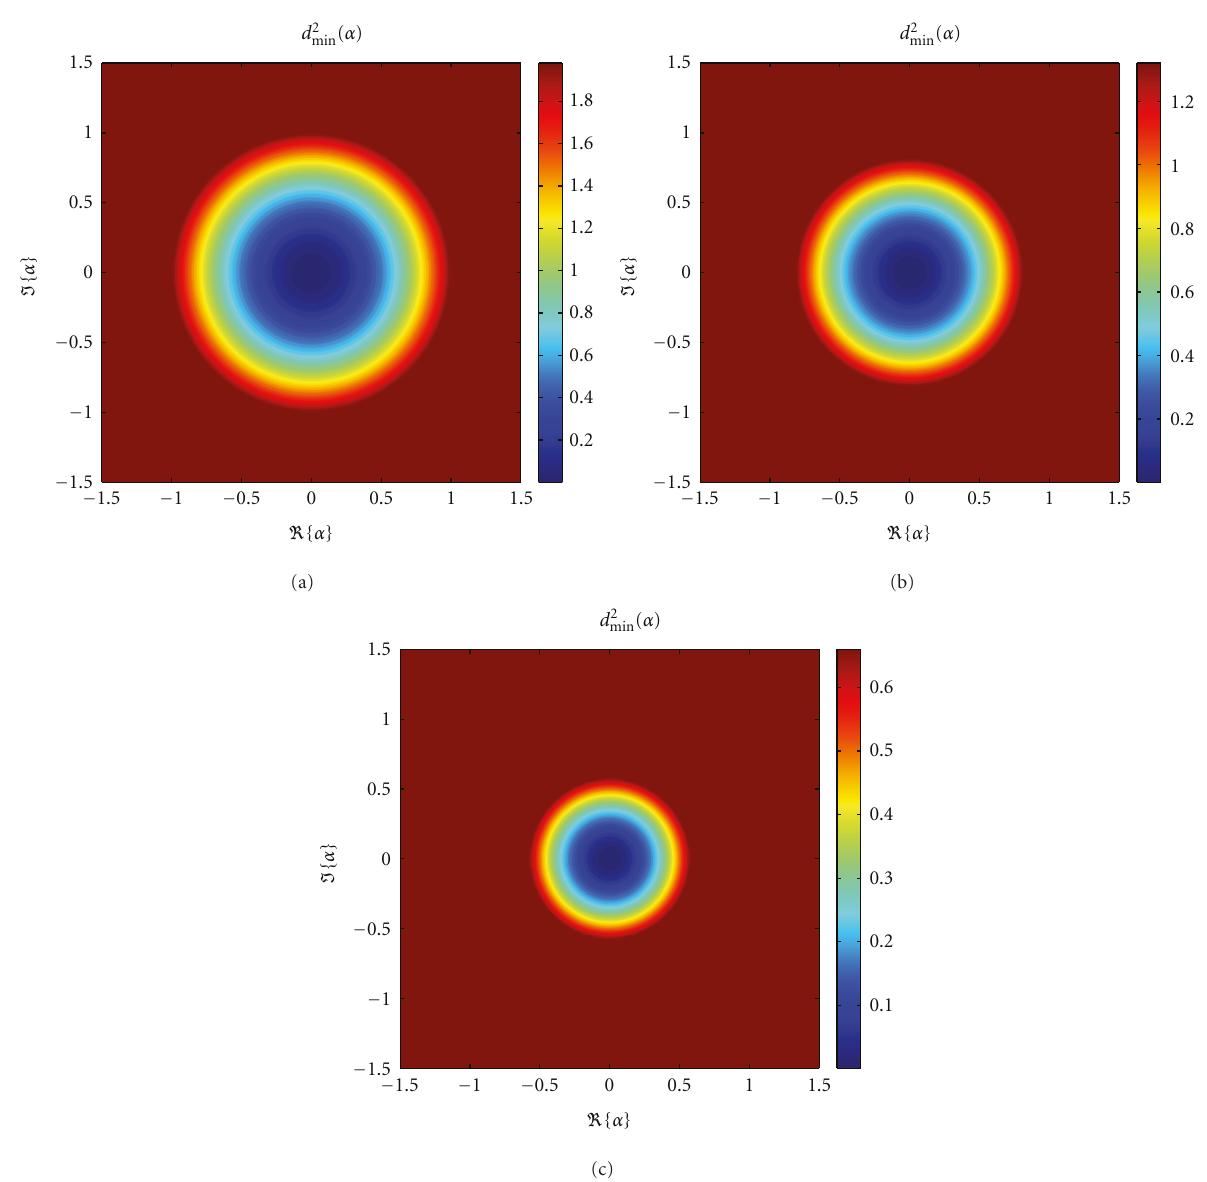
Figure 11: Hierarchical minimum distance for 4-ary example codebooks ( (cid:12) v (cid:12) ∈ { 0,1,2 } ).